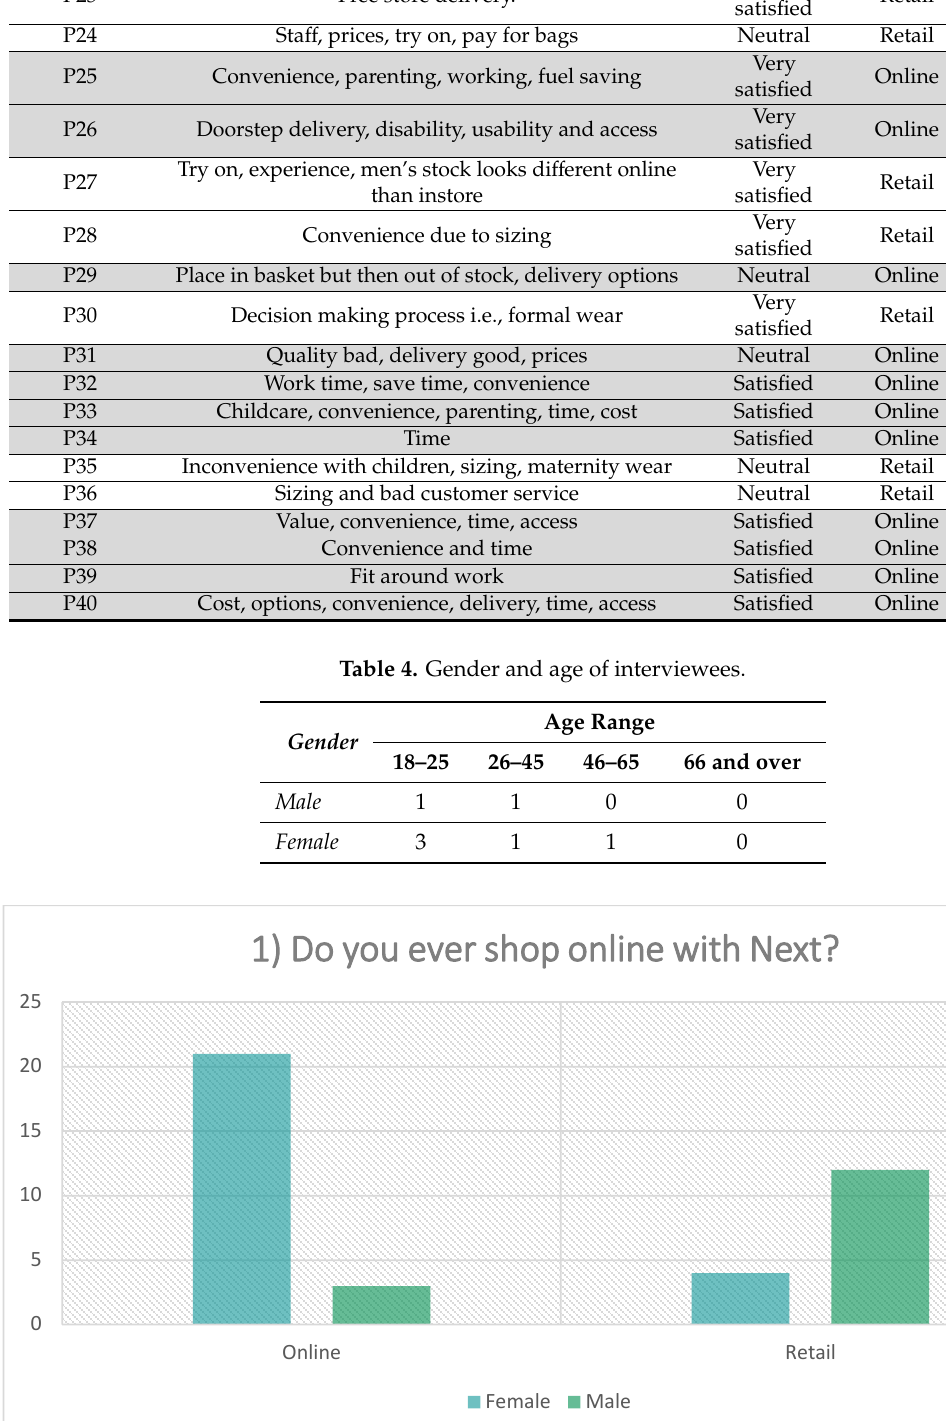
Figure 2. Responses from Question 2: On a scale of 1–5 how would you rate your experience? 4.1.2. Question 2: On a Scale of 1–5 How Would You Rate Your Experience? Questionnaire responses for the second question suggested that 75.5% of respondents were either satisfied or very satisfied with their experience. Specifically, 86% of male respondents were satisfied by their experience, and a further 14% felt neutral about their experience. Whereas, 72% of female respondents were satisfied by their experience, 20% felt neutral and the remaining 8% felt unsatisfied or very unsatisfied about their experience. In contrast to more males shopping in store than females, as outlined in Question 1, it is an interesting finding that no males were unsatisfied with their experience at all and the question here may be that due to male’s preferring to shop in store, they have a lower expectation rate of pricing, products and the promotion of them—whereas female shoppers who have mainly shopped online due to commitments such as parenting, have been open to a vast domain of omni channel opportunity and thus this enabled them to have higher expectations from retail stores and the quality and pricing of product in front of them. However, with no male respondents unsatisfied with their experience at all, this is also a potential research area for future study and has also been explored through the semi-structured interviews in this study. To investigate this question in more detail, it has been supported by Question